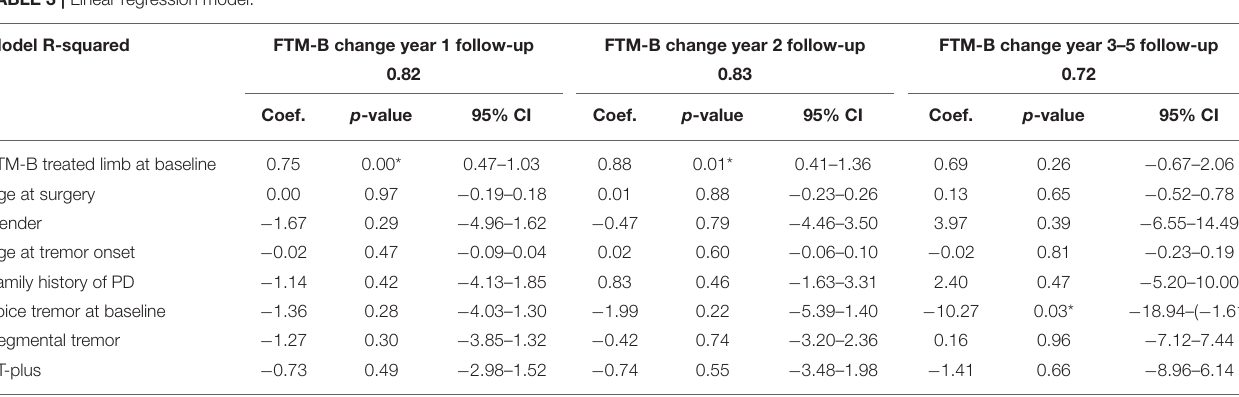
TABLE 3 | Linear regression